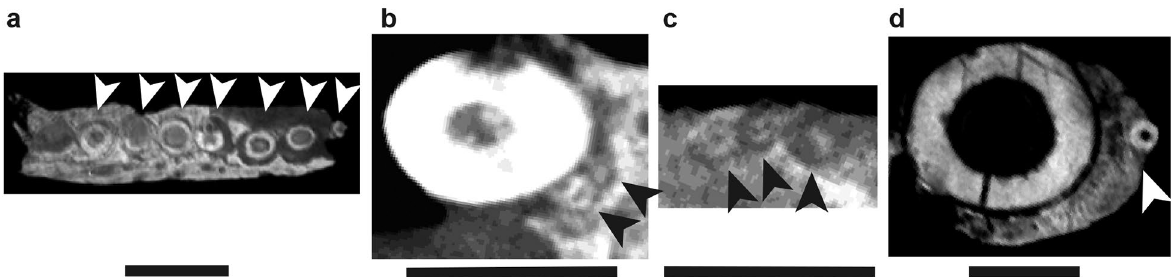
Figure 4. µCT scans of mandibular ‘postcanine’ teeth in horizontal section showing evidence for a gomphosis at the base of Dicynodontia. ( a ) Patranomodon nyaphulii maxillary teeth (NMQR3000, mirrored), ( b ) Eodicynodon oosthuizeni tusk and maxillary ‘postcanines’ (BPI/1/6230), ( c ) Eodicynodon oosthuizeni mandibular teeth (BPI/1/6230, mirrored), ( d ) Eodicynodon oosthuizeni tusk and maxillary tooth (NMQR 2978, mirrored). Scale bar 5 mm. Anterior is to the left, lingual is up. Arrows indicate ‘postcanine’ Tooth attachment. Most extant reptiles have their functional teeth fused to the jaw bone (ankylosis), whereas mammals, crocodilians, and a growing list of extinct amniotes have a soft-tissue attachment of teeth to bone (gomphosis), mediated by the periodontal ligament 96,97 . Recent work has shown that all teeth have a gomphosis early in development, meaning that the dichotomy between a gomphosis and ankylosis actually reflects two ends of an ontogenetic spectrum of tooth attachment tissue mineralization 7 . A gomphosis has been documented in several non-mammalian therapsids 69,72 , including the dicynodonts Abajudon 47 (‘postcanines’) and Lystrosaurus (tusks) 98 . In the anomodonts examined here, the CT scans show